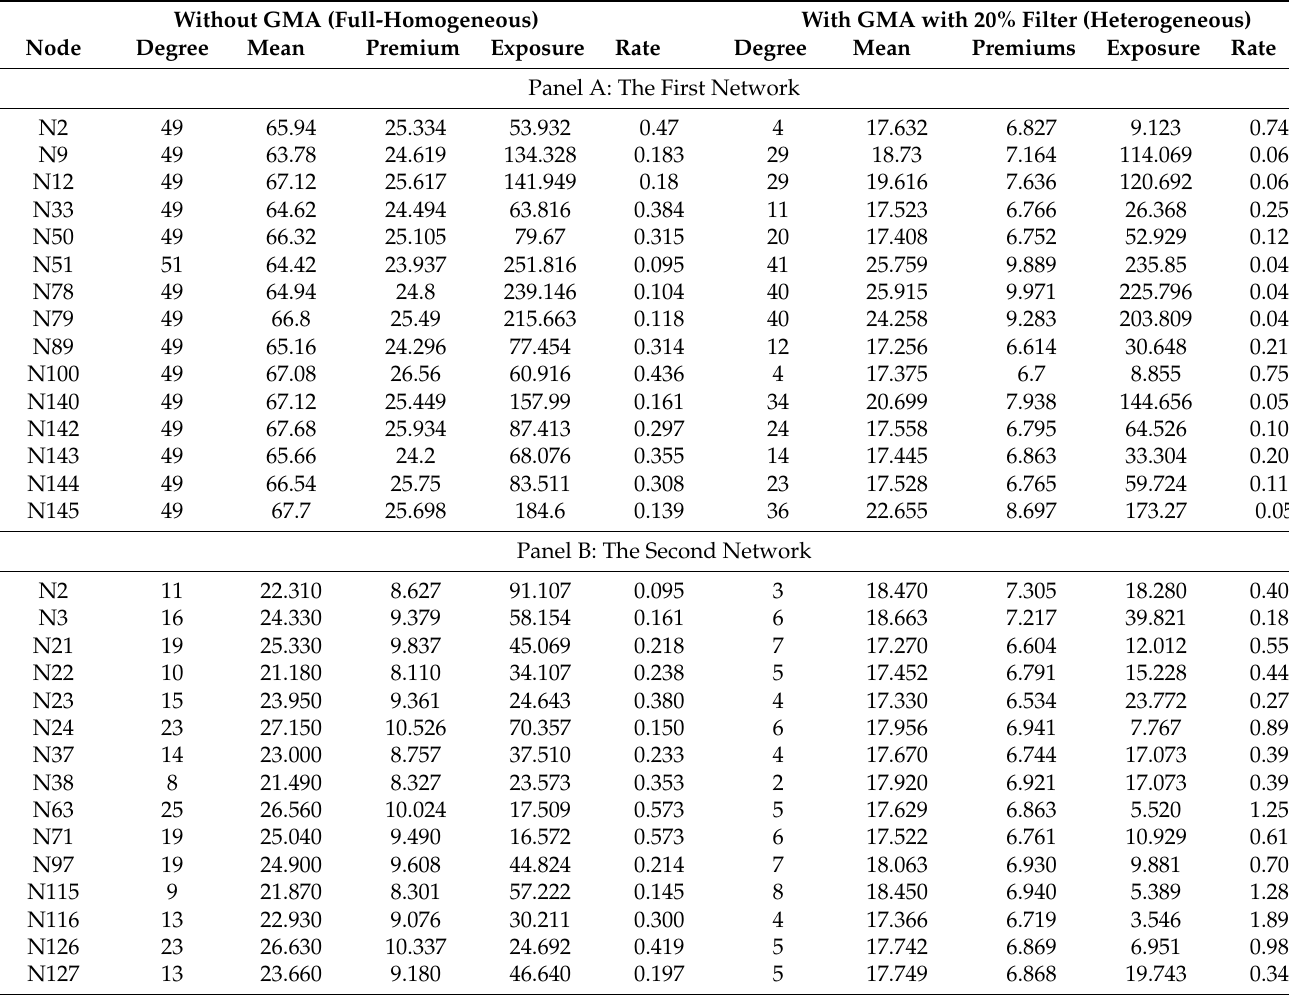
Table 7. Premiums and rates for the 15 selected nodes without GMA and with GMA with a 20% filter. Without GMA (Full-Homogeneous) With GMA with 20% Filter